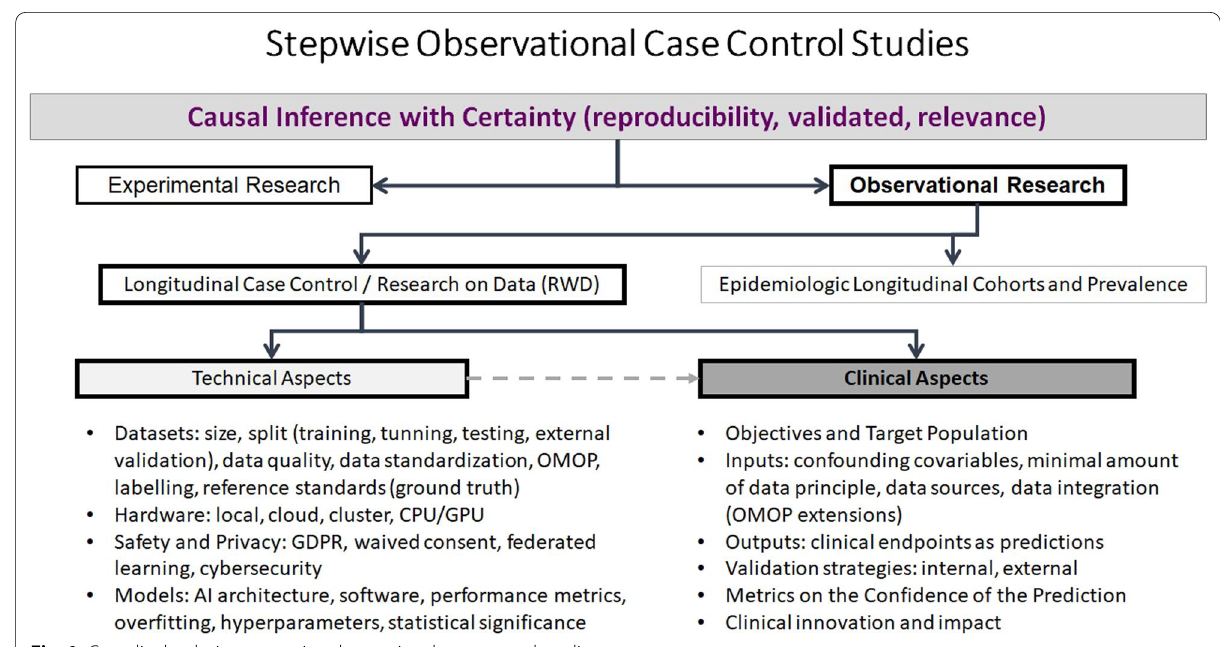
Fig. 1 Causality by design: step wise observational case control